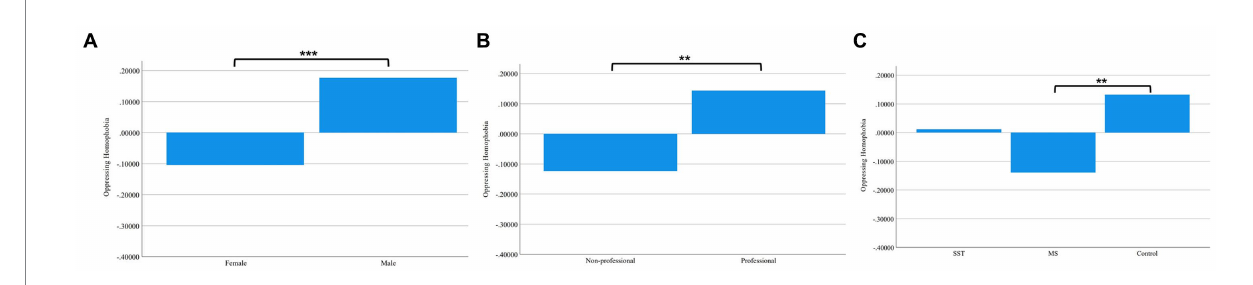
FIGURE 1 Group Differences in Oppressing Homophobia. (A) Differences between Female and Male. (B) Differences between Non-professionals and Professionals. (C) Differences among Sexual Strategies Theory Group, Minority Stress Group, and Control Group.